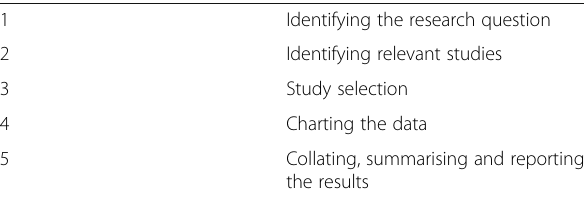
Table 1 Arksey and O'Malley scoping review